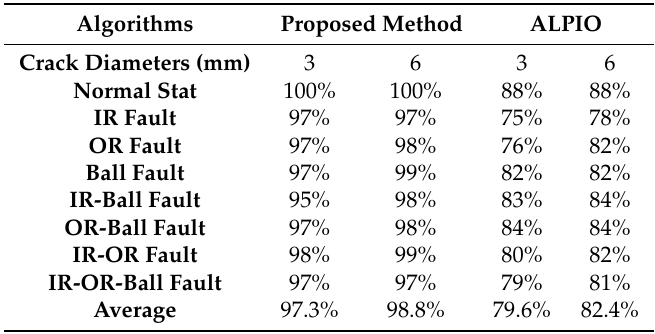
Table 4. Fault diagnosis results using dataset 3 with the proposed method and ARX-Laguerre proportional integral observation (ALPIO) when the torque speed is 450 RPM.